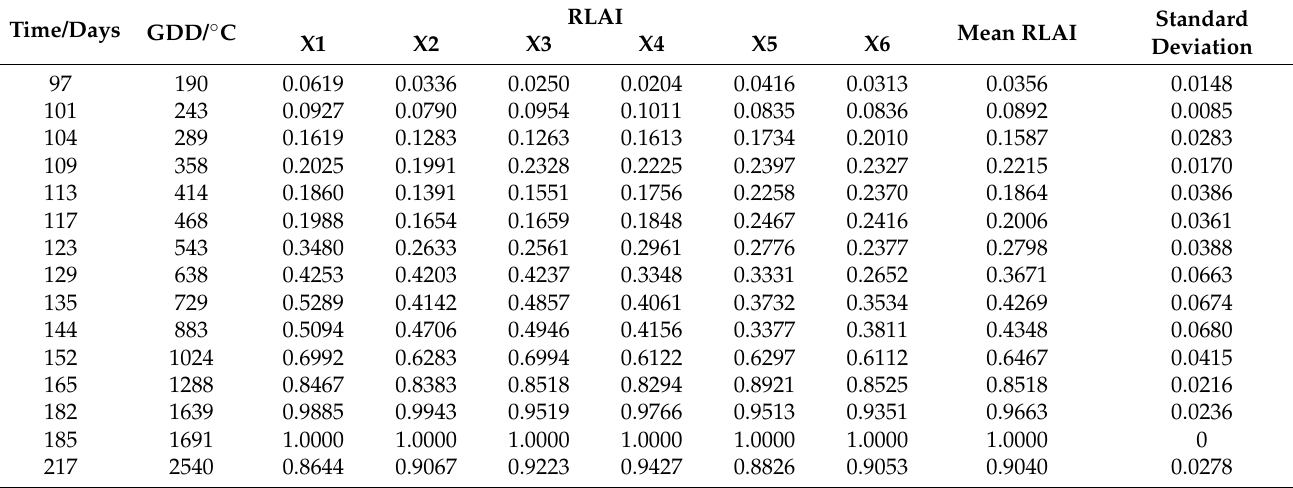
Table 2. Relative leaf area index (RLAI) values for the six different treatments at different points in time and mean RLAI values for all treatments in 2009.